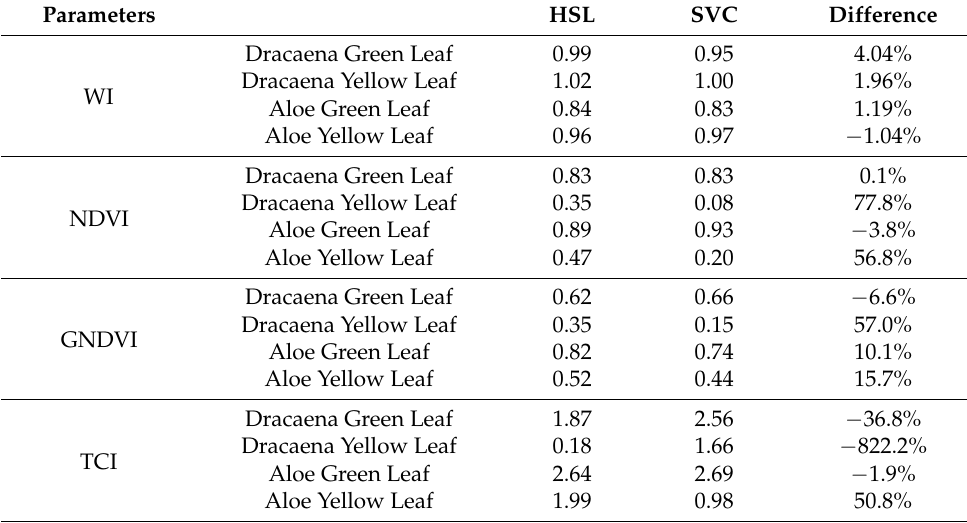
Table 4. Spectral indexes results comparison.